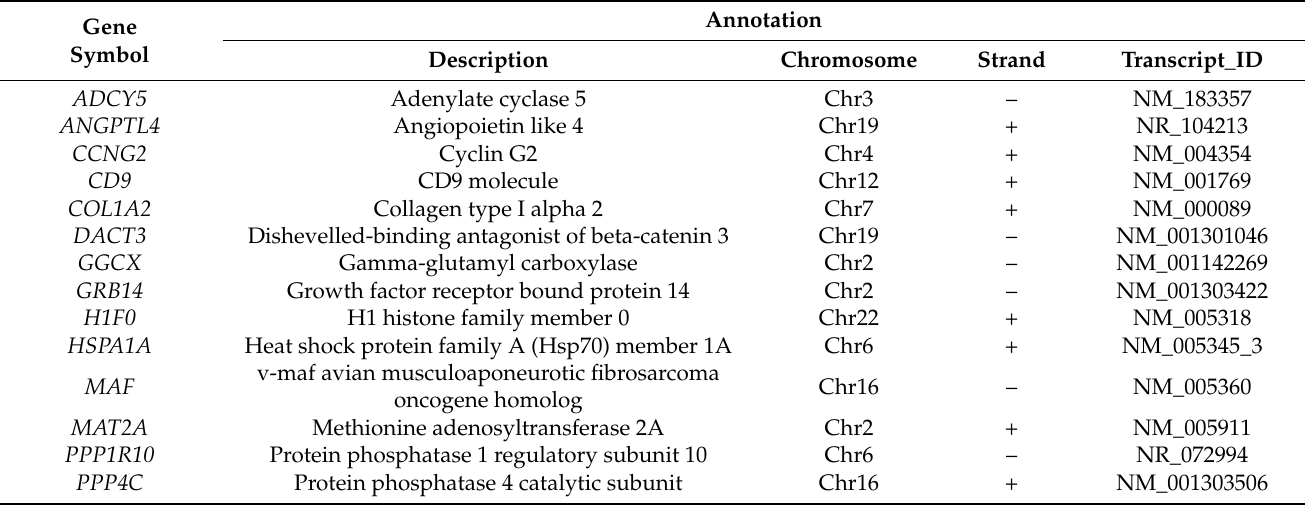
Table 1. Biomarker candidates for assessment of sodium cyanide